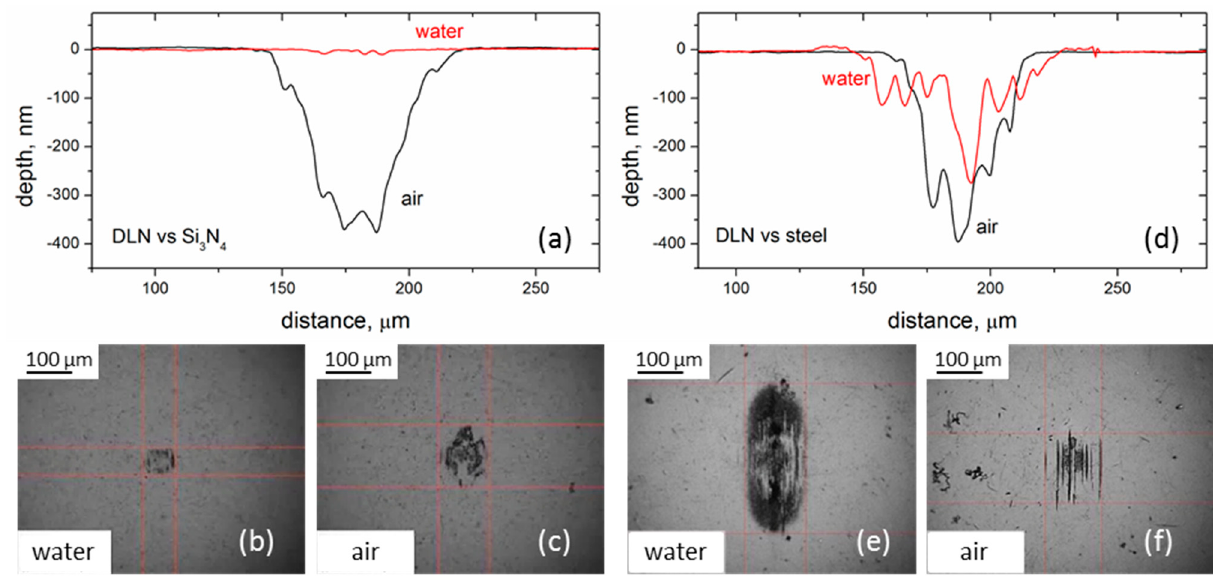
Figure 2. Friction performance of the DLN films during sliding against 100Cr6 steel and Si 3 N 4 balls in ambient air (RH = 50%) and distilled water; the load 0.5 N, the sliding speed 5 cm/s.